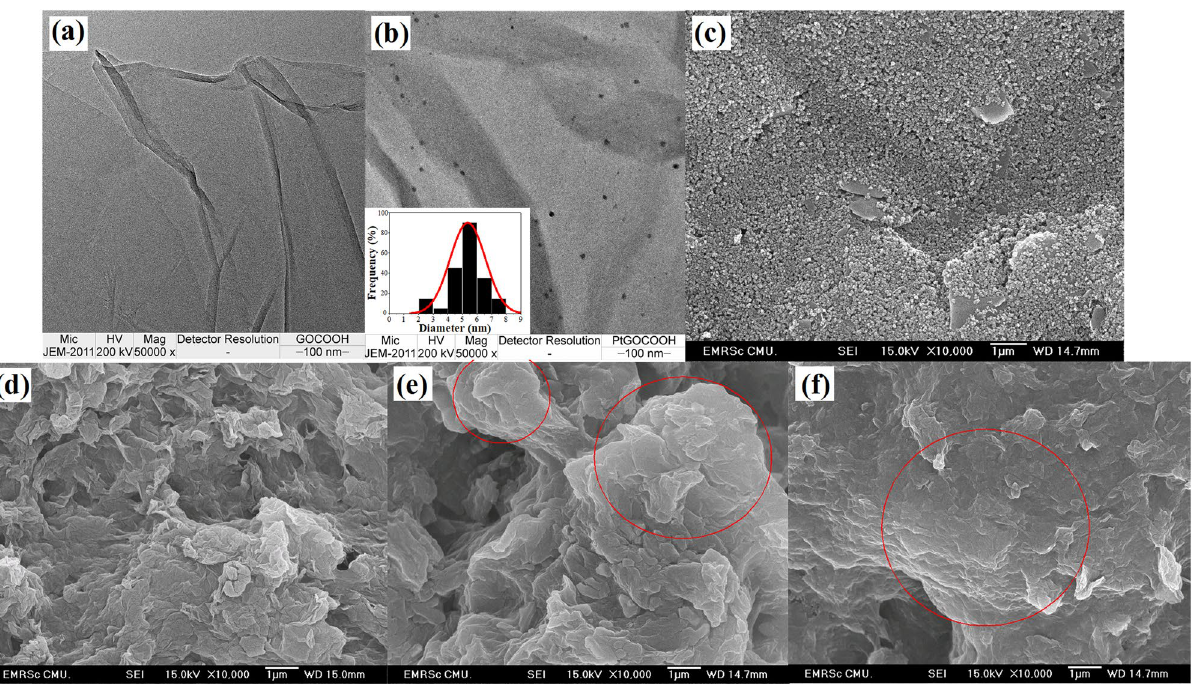
Figure 4. TEM images of ( a ) GO-COOH and ( b ) PtNPs/GO-COOH, and SEM images of ( c ) bared SPGE, ( d ) PtNPs/GO-COOH/SPGE, ( e ) Apt/PtNPs/GO-COOH/SPGE, and ( f )